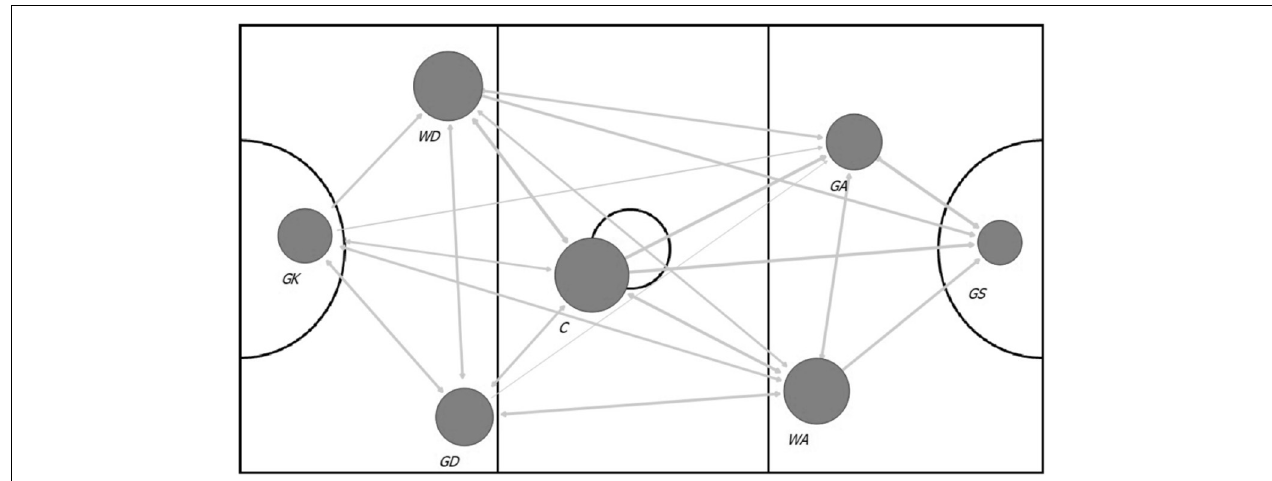
FIGURE 3 | Network analysis diagram of passing in a netball match. The direction of attack is from left to right. In this conceptual example, the node (player) size is based on degree centrality (number of outward passes in the match). The larger nodes represent more passes made, and the edges (passes) are weighted by frequency of passes completed between players, e.g., thicker lines indicate a greater frequency of passes. GK (goalkeeper), GD (goal defense), WD (wing defense), C (center), WA (wing attack), GA (goal attack), GS (goal